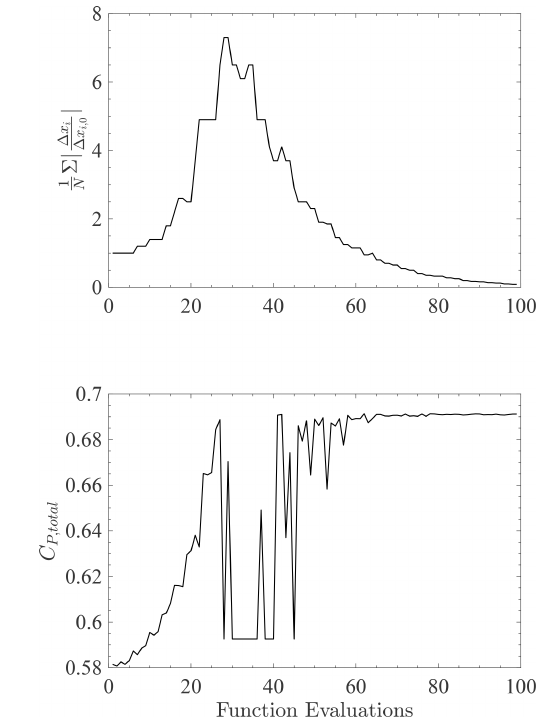
Figure 5. Convergence of the optimization technique to the optimal